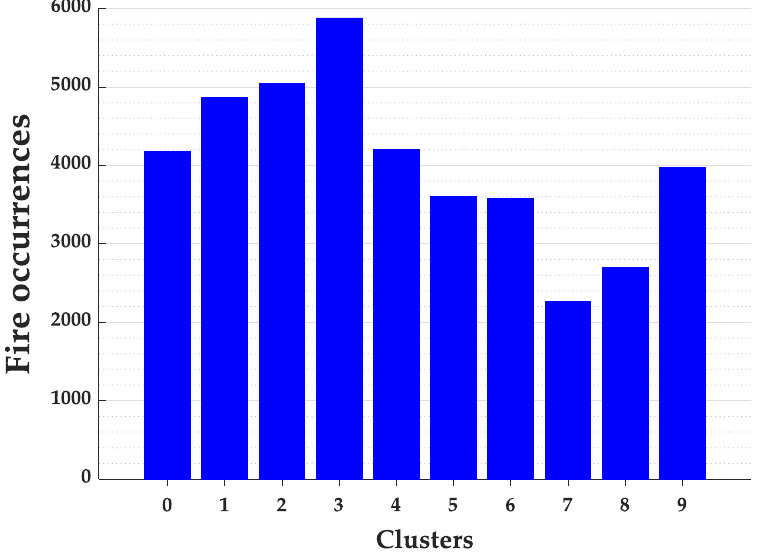
Figure 14. Fire occurrences for each cluster of the Mato Grosso State.